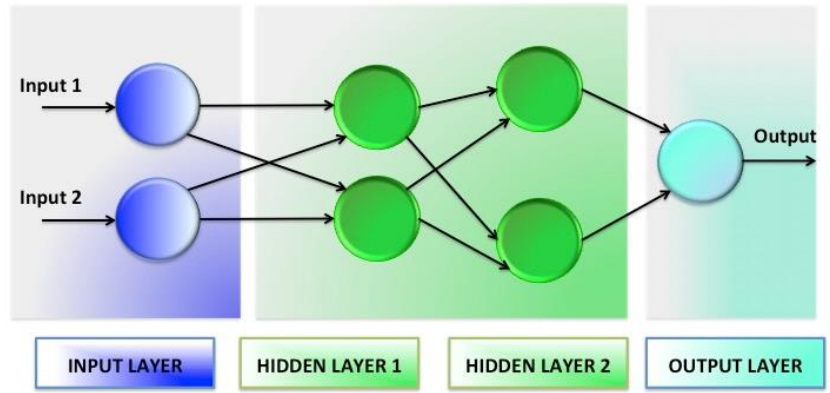
Figure 5. A multi-layer feedforward ANN of the vibration generator model with an input layer, two hidden layers, and an output layer.